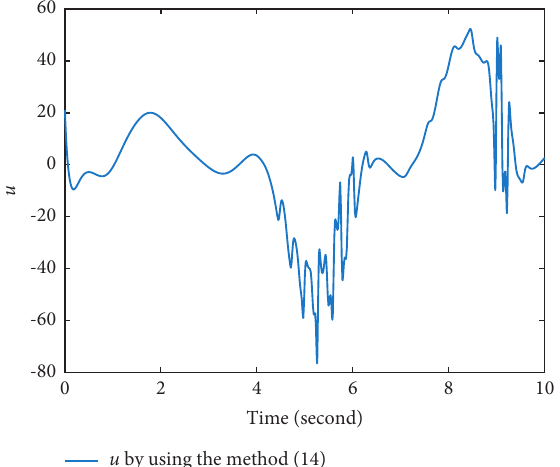
Figure 5: Time response trajectories of x and x ( t ) . (14) under ρ 1